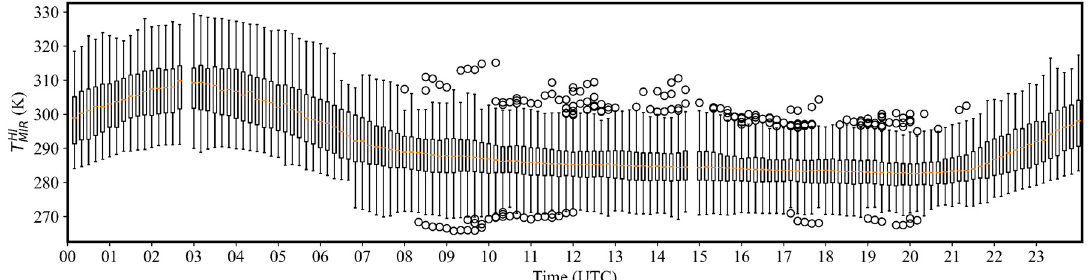
Figure 10. Box-and-whisker plots of T HI values (over 12-months) plotted per the AHI timepoint for IBRA sub-region SEH01 (within the SEH biodomain). For orienting information, please see Figures 6 and 9.